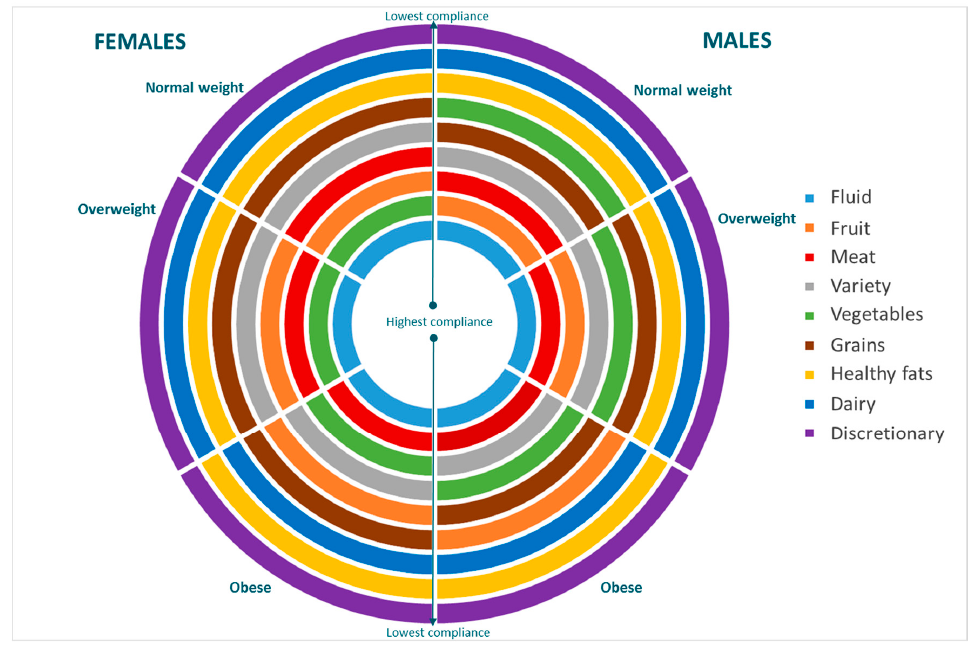
Figure 1. Rank order of Dietary Guideline compliance scores, by gender and weight status.